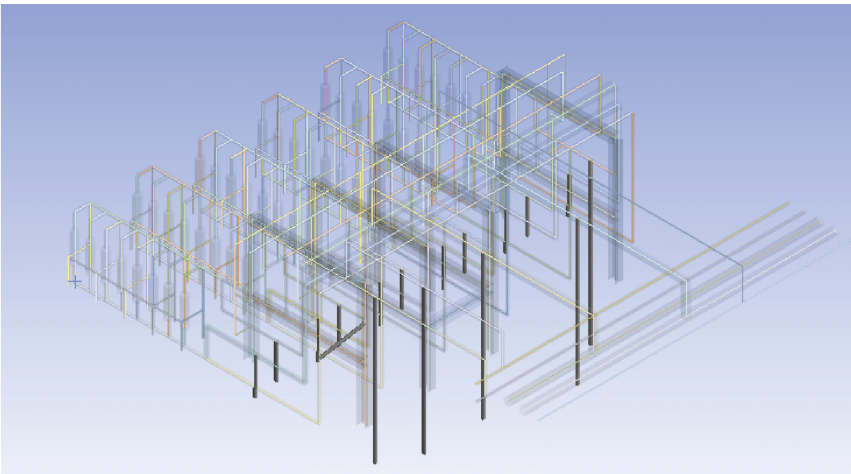
Figure 20: Additional constraints in Solution 2.